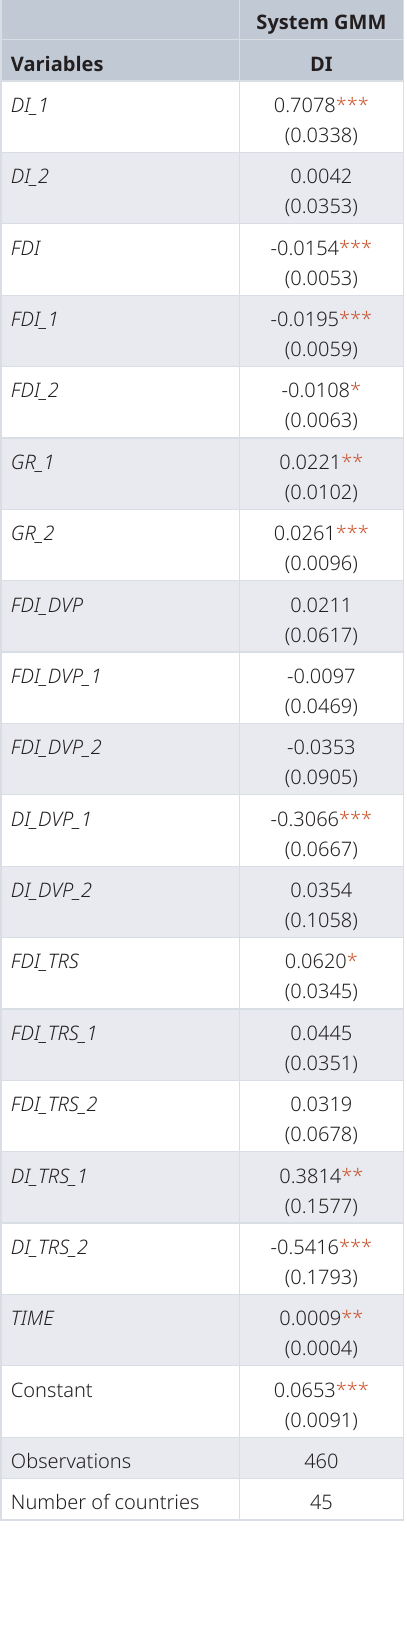
Table 7. Results of the main model, model 4.